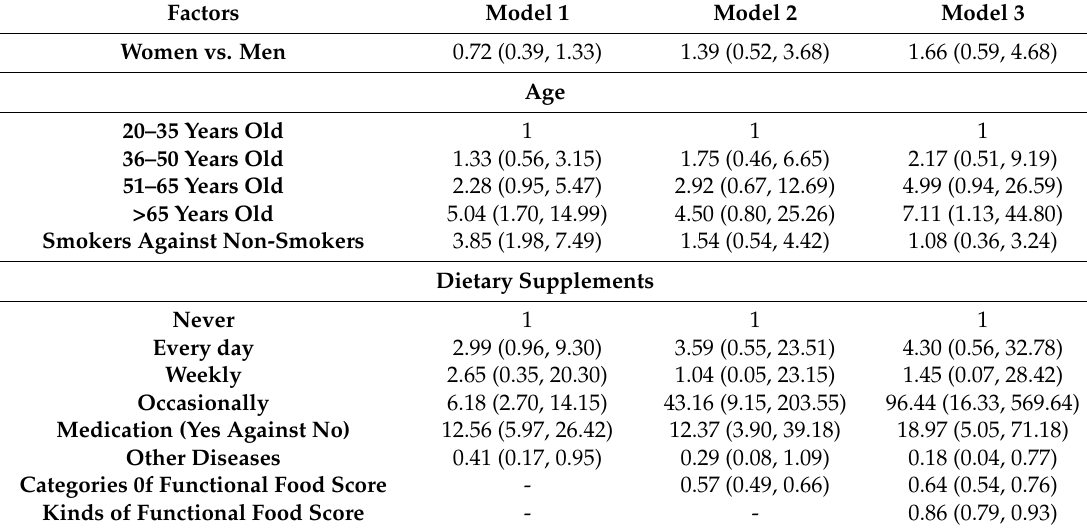
Table 5. Multifactorial analysis results for the relationship between the scores for functional food categories and for functional food kinds and the likelihood of gastrointestinal diseases based on gender, smoking, medication, and supplements